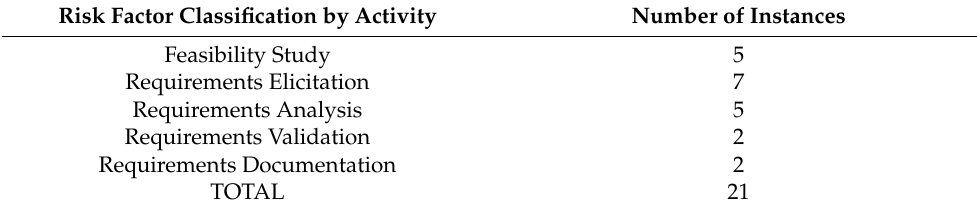
Table 1. The requirement definition and analysis stage risk factors.